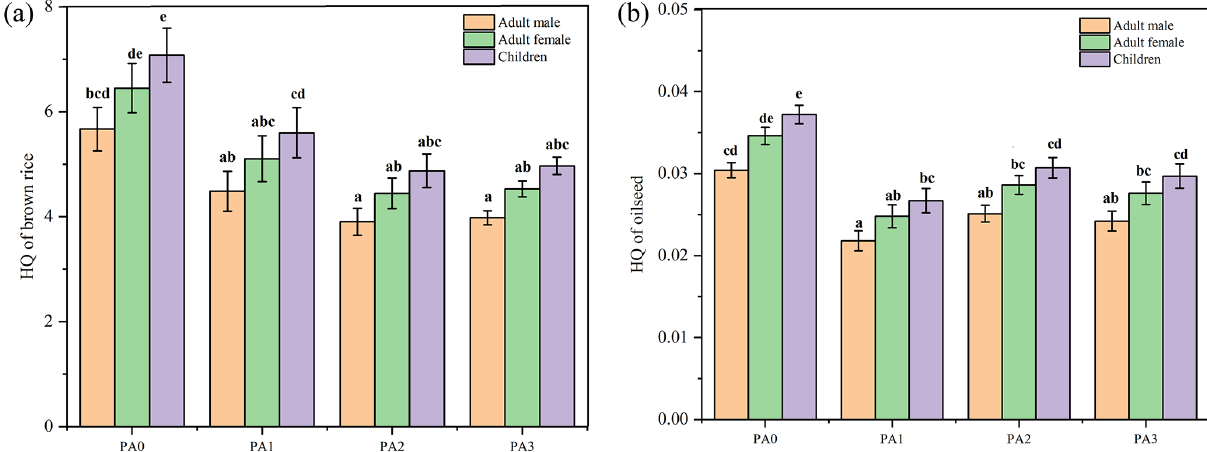
Figure 4. The effects of different amendments on the HQ of grown rice and oilseed. Mean values with different lowercase letters indicate the significant ( p< 0 . 05) difference from each other according to the LSD test. Values represent means ± standard